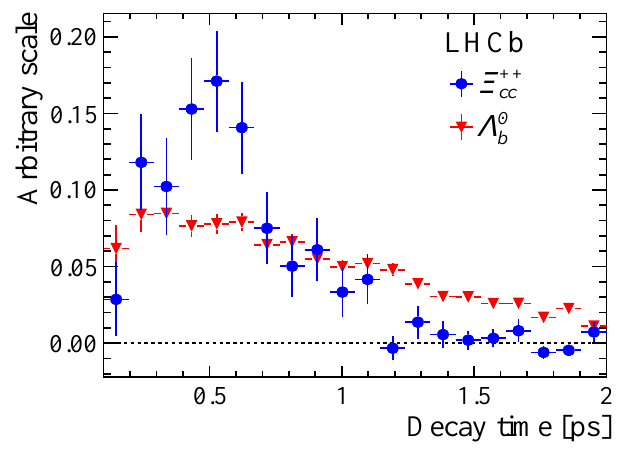
Figure 3. Background subtracted decay time distribution for the Ξ ++